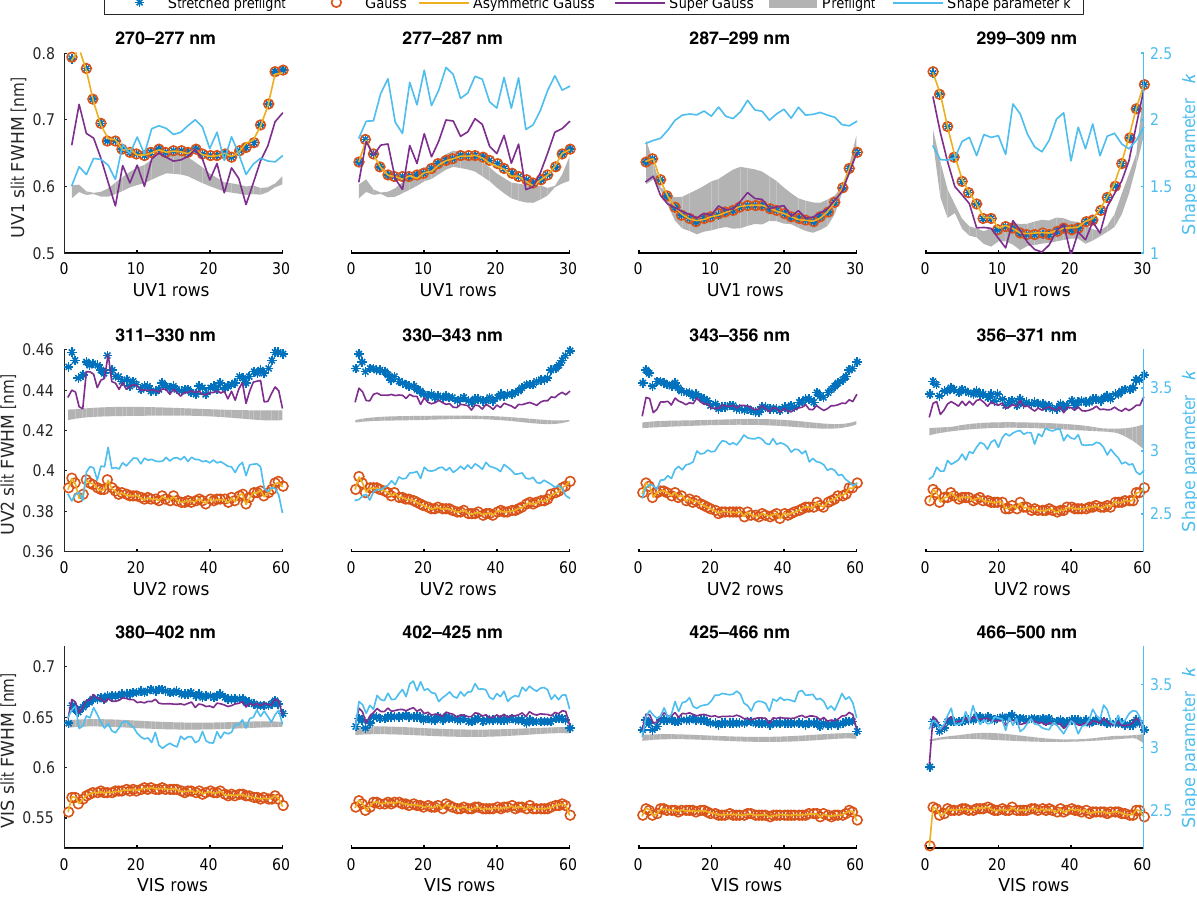
Figure A1. Similar to Fig. 3 but using averaged solar spectra from January 2007 to January